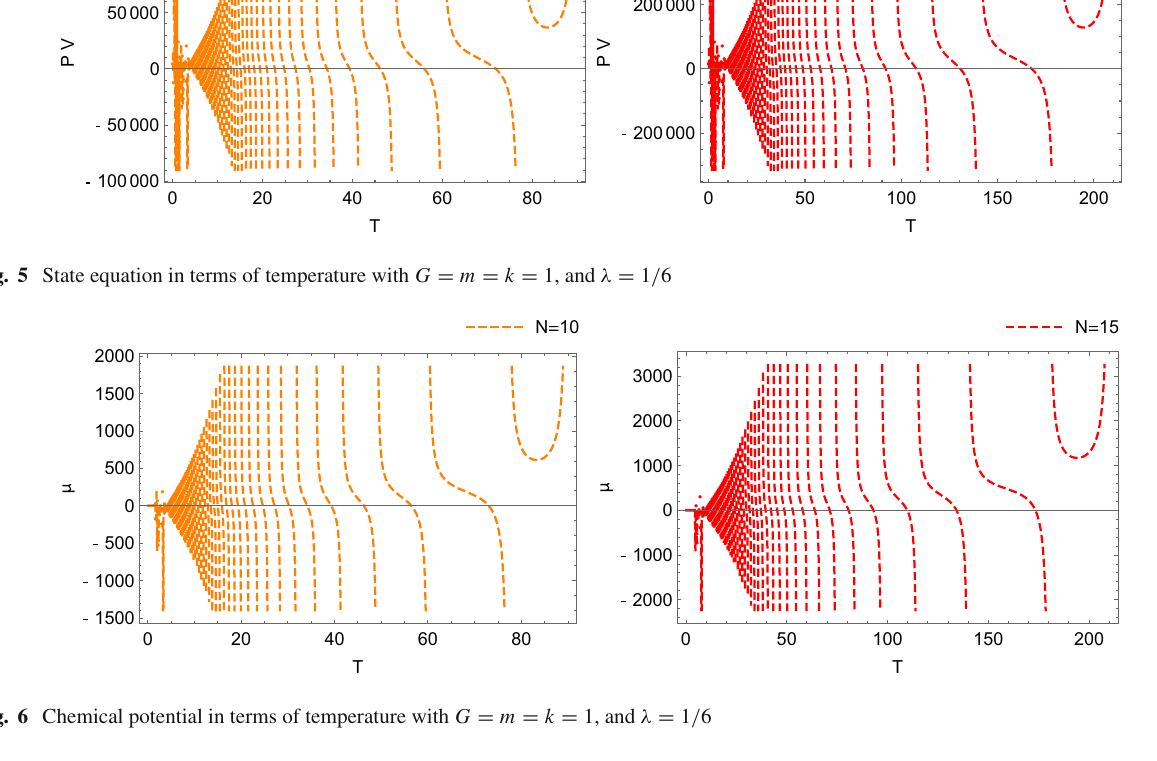
From chemical potential μ we find the fugacity z as z N = e N βμ